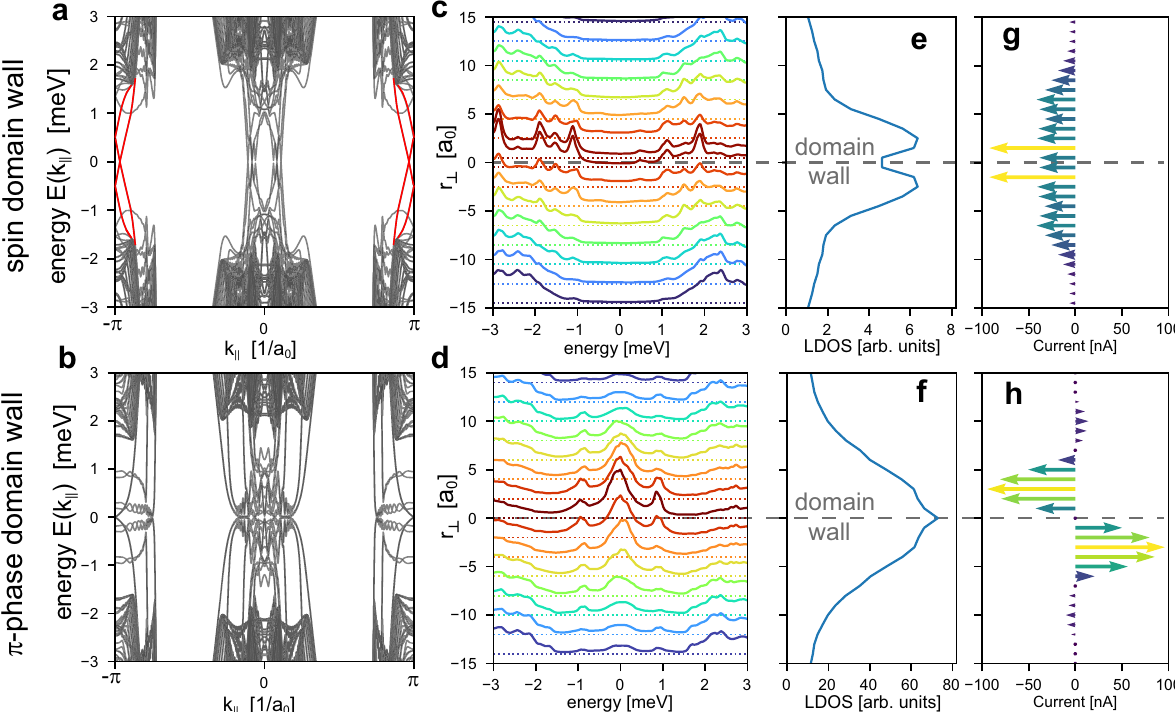
Fig. 4 Chiral Majorana modes along domain walls. Electronic band structure as a function of momentum k ∥ along the domain wall for a a spin, and b a π - phase domain wall. Energy-resolved local density of states for c the spin, and d the π -phase domain wall along a linecut perpendicular to the domain wall. The position of the domain wall is indicated by a dashed gray line. Spatial plot of the zero-energy local density of states for e a spin, and f a π -phase domain wall. Spatial distribution of supercurrents near g the spin, and h the π -phase domain wall. For both domain walls, ( α , Δ μ ) = (7, 0) meV, with JS = ±7.5 meV corresponding to domains with Chern number C = ±1 separated by the spin domain wall. Here, α is the Rashba spin – orbit coupling, and JS is the magnetic exchange